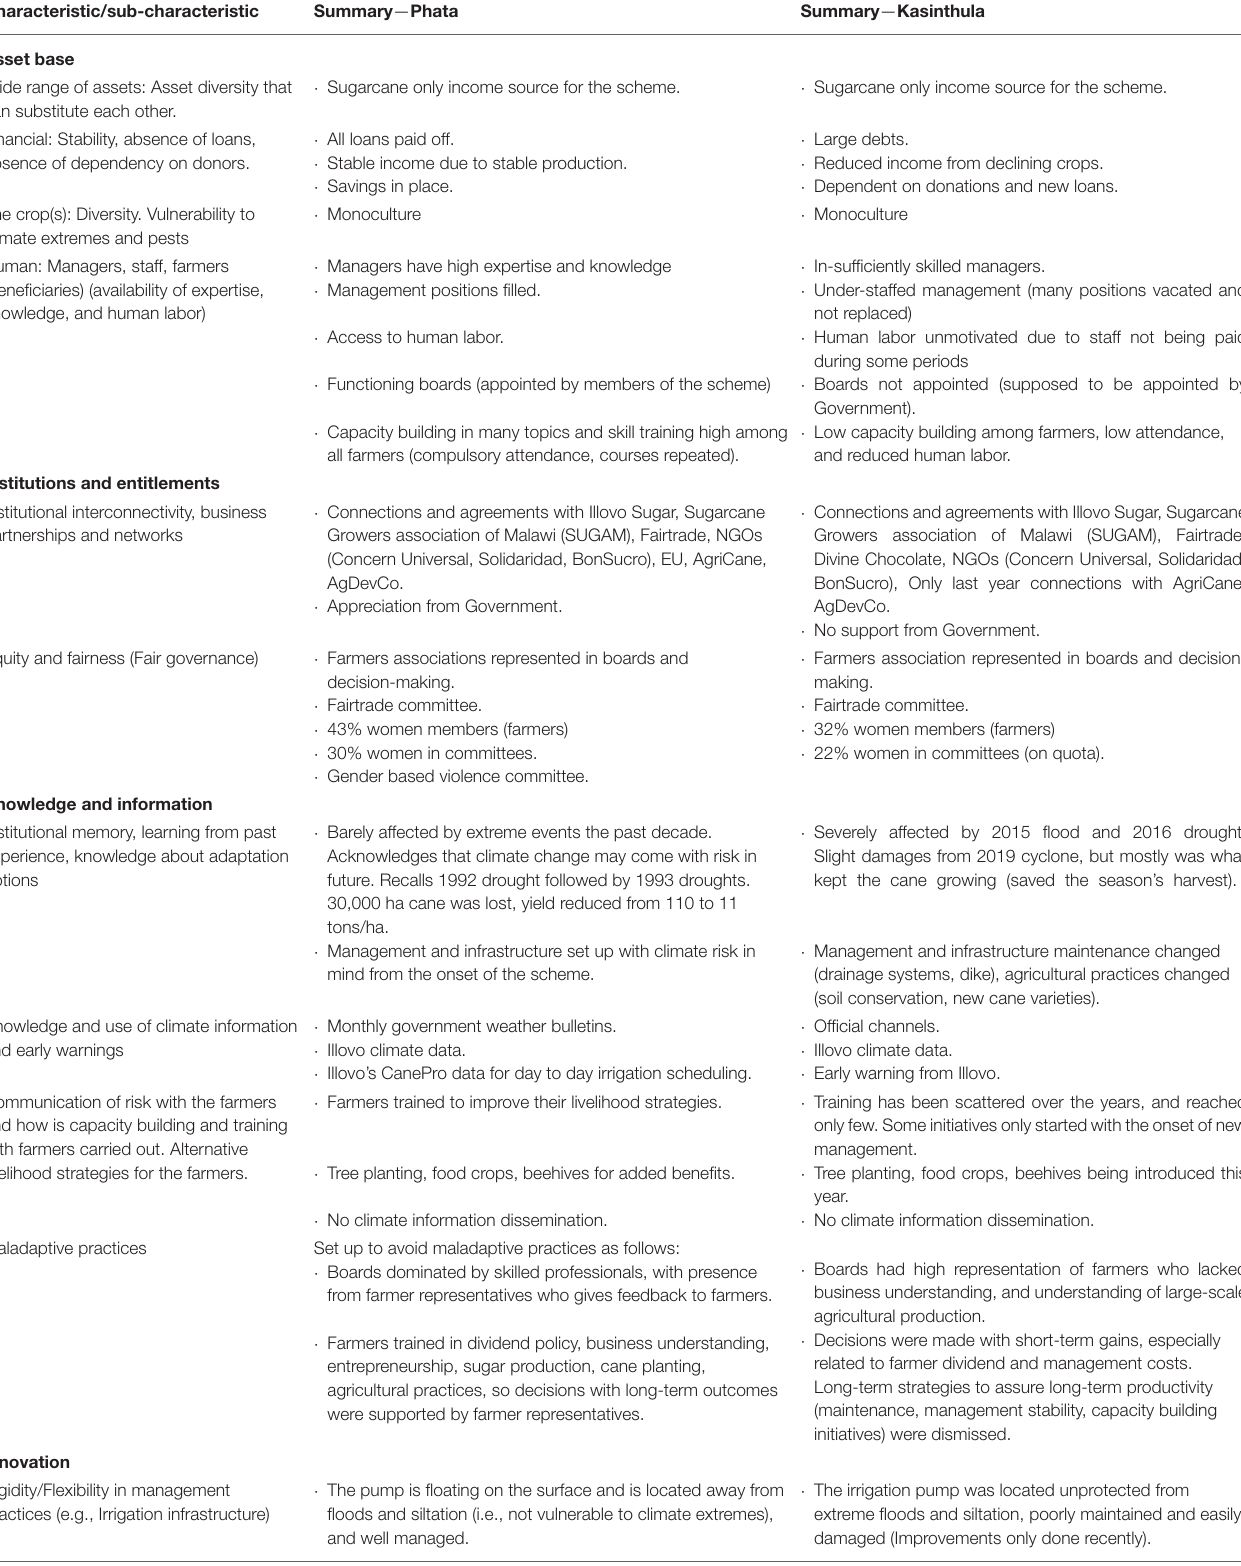
TABLE 3 | A summary of the mechanisms and features of two sugarcane outgrower schemes (Phata and Kasinthula) corresponding to various aspects of adaptive capacity, obtained through in-depth interviews with scheme